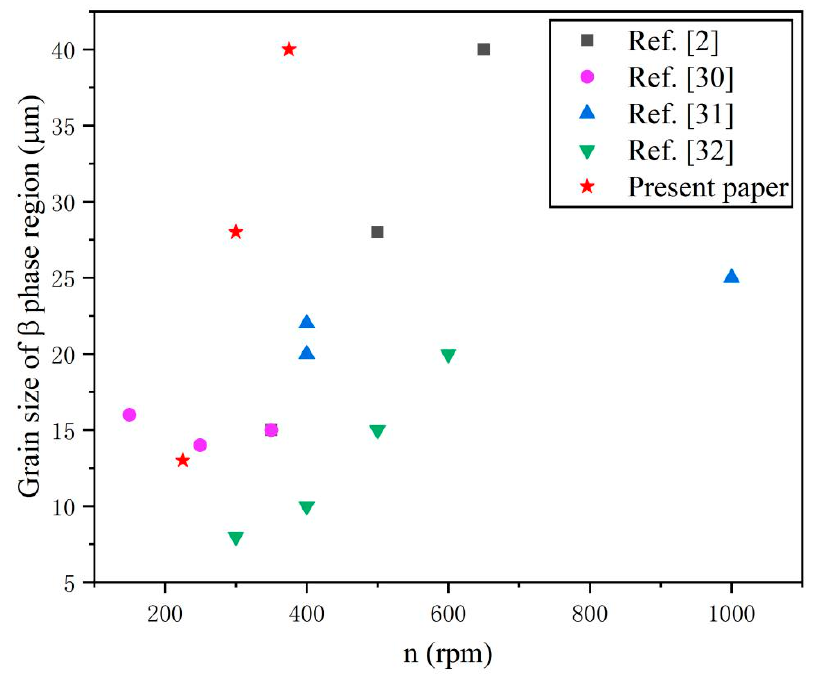
Figure 3. Grain size variation of β phase region in the FSPed TC4 alloy reported in previous